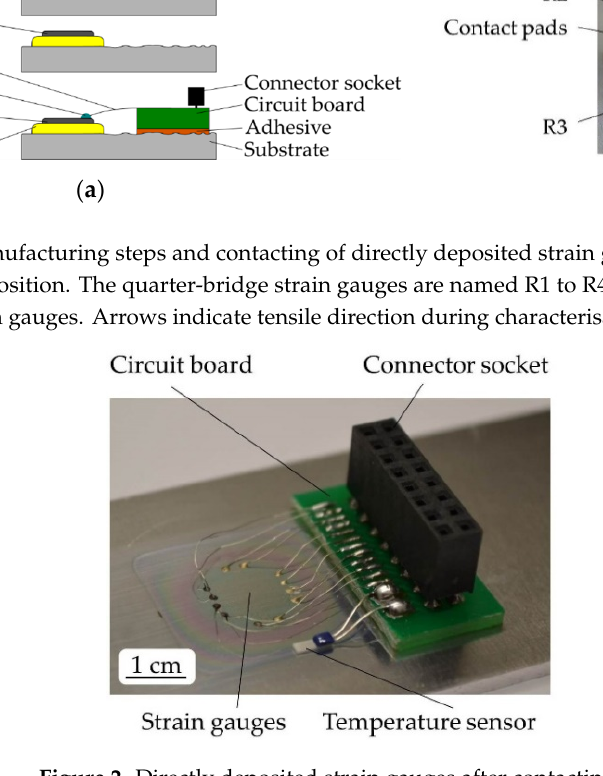
Figure 2. Directly deposited strain gauges after contacting.